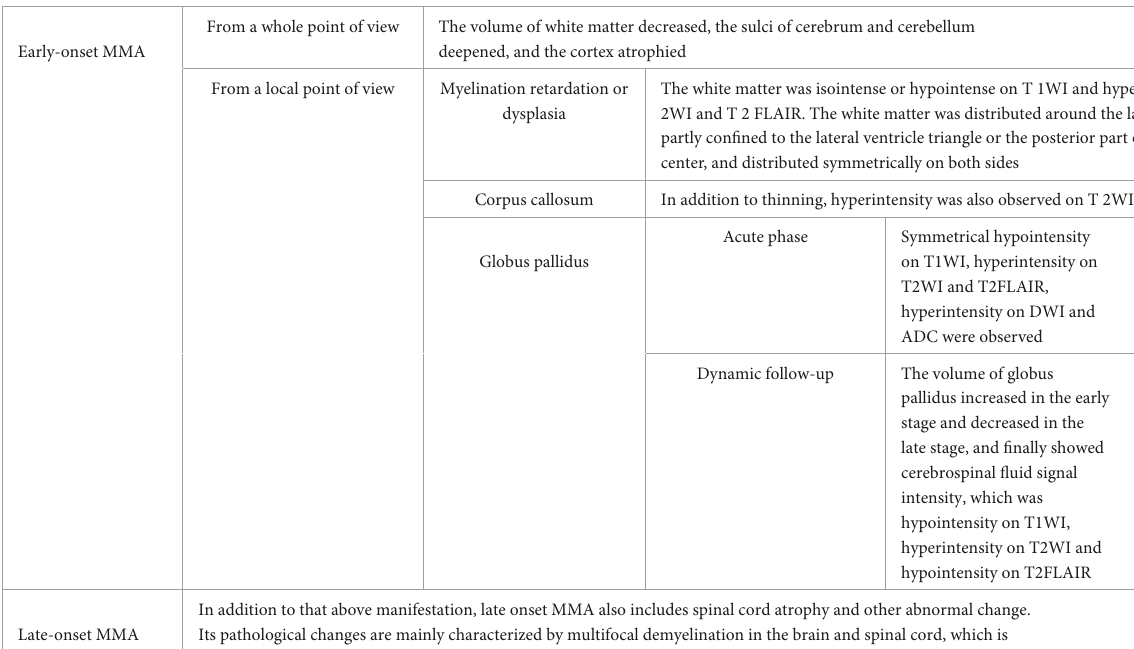
TABLE 2 Imaging manifestations of MMA.